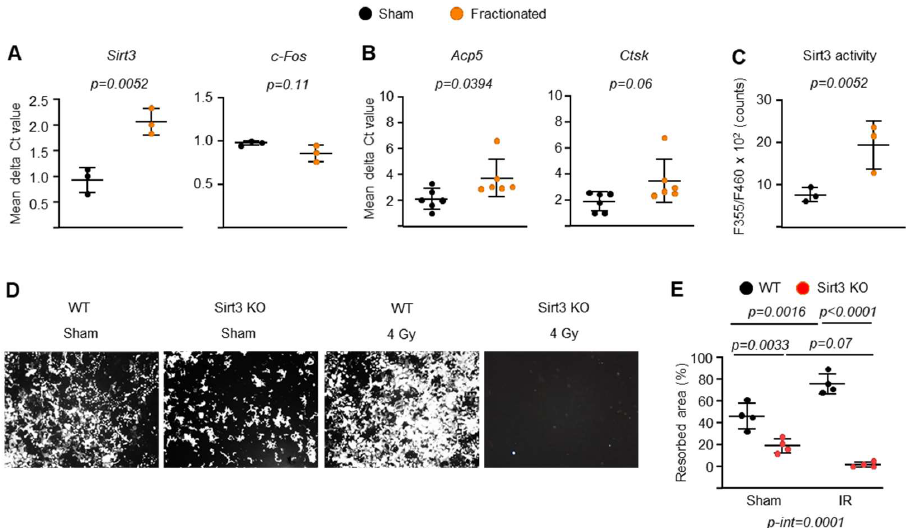
Figure 6. IR activates mitochondrial Sirt3 in osteoclasts. ( A , C ) BMMs were isolated from 8.5-month- old male C57BL/6 sham- or IR-exposed mice 10 weeks after irradiation and cultured with M-CSF (30 ng/mL) and RANKL (30 ng/mL) for ( A ) 3 or ( C ) 2 days. ( A ) Sirt3 and c-Fos levels in mRNA of cultured osteoclasts measured by qPCR. ( B ) Osteoclast marker levels in mRNA of lumbar vertebra (L1) measured by qPCR. ( C ) Sirt3 enzymatic activity in cultured osteoclasts measure by fluorescence reader. ( D , E ) BMMs were isolated from 6-month-old male Sirt3-knockout mice and WT littermates and cultured with M-CSF (30 ng/mL) and RANKL (30 ng/mL) for 5 days. 4 Gy γ-irradiation was subjected to pre-osteoclasts after 3-day cultures. ( D ) Representative pictures and ( E ) resorbed areas of Von Kossa–stained bone biomaterial surface. The resorbed areas appear white and the unresorbed mineralized surface appears black. Data are presented as ± SD. p values were determined using Student’s t test ( A – C ) or 2-way ANOVA ( E ). All measures were performed in cultured BMMs pooled from 3 mice/group. Interaction terms generated by 2-way ANOVA are shown below the graph.